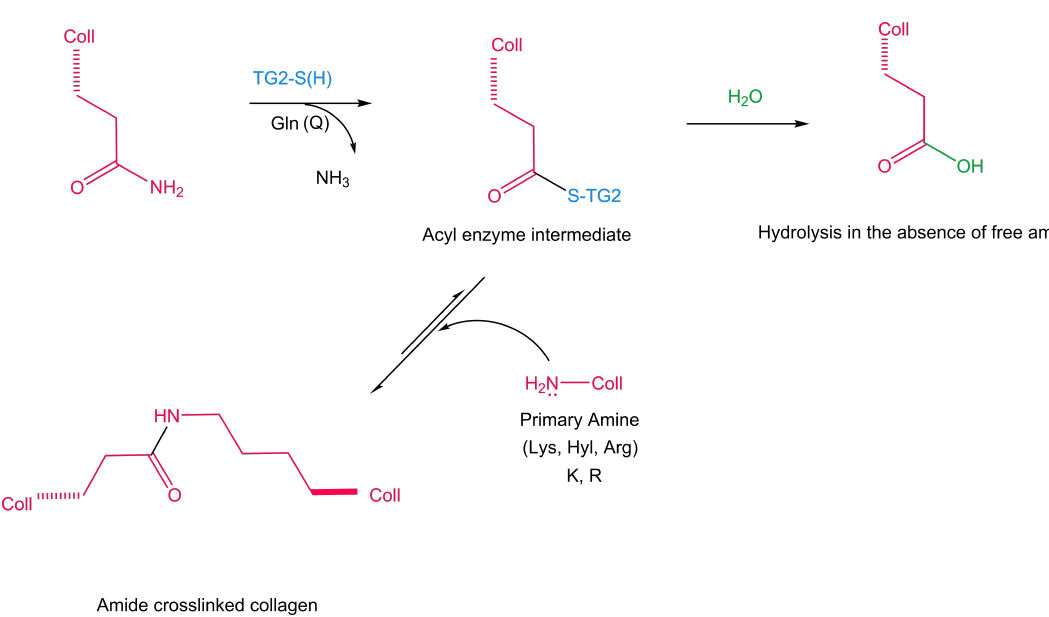
Figure 6. Crosslinking mechanism of tissue transglutaminase. Illustration of proposed mechanisms by Keillor et al. [39]. Image modified from Nair et al. [14] licensed under CC-BY